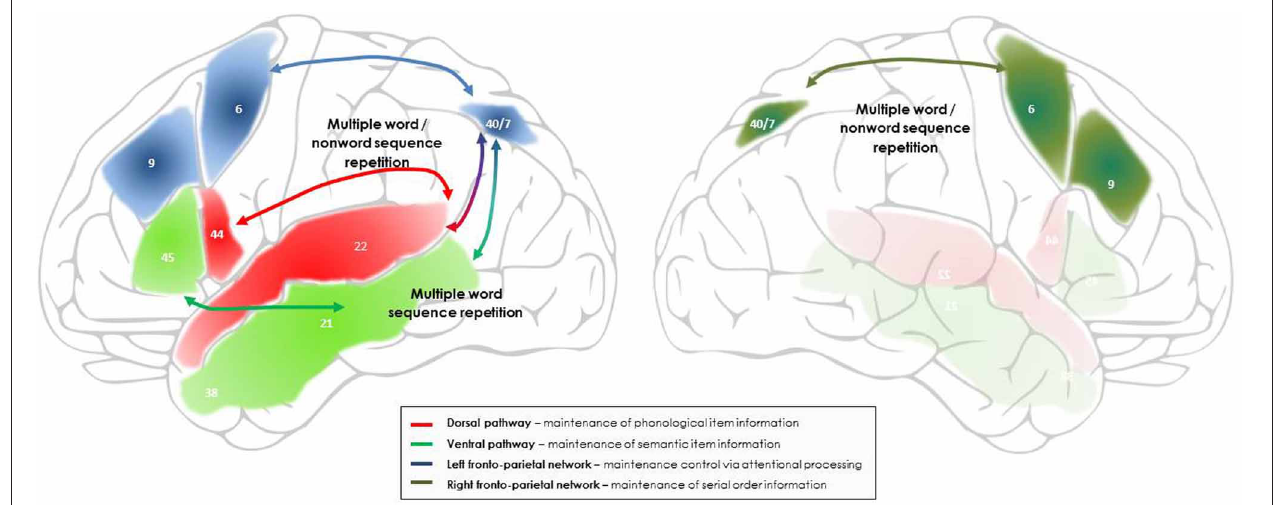
FIGURE 2 | Outline of the networks and processes proposed to support maintenance during multiple non-word and word sequence repetition, including sentence repetition. Bilateral fronto-parietal networks, supporting domain-general attentional and serial order processing, intervene in addition to the dorsal and ventral language pathways involved in the maintenance of phonological and semantic item information. In the left hemisphere, the fronto-parietal network associating the left intraparietal sulcus to the left superior and middle prefrontal cortex is proposed to support the maintenance of multiple verbal stimuli by